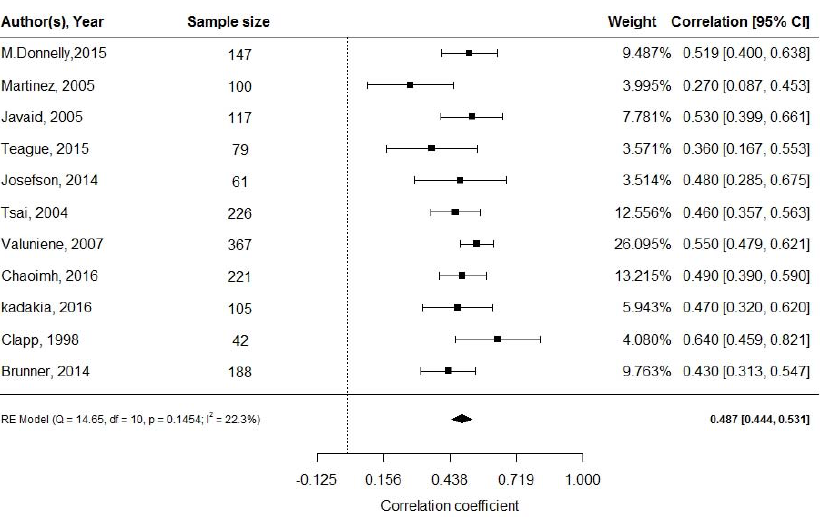
Figure 2. Cord blood leptin and fat mass at birth; df: degree of freedom, RE: random effects model.